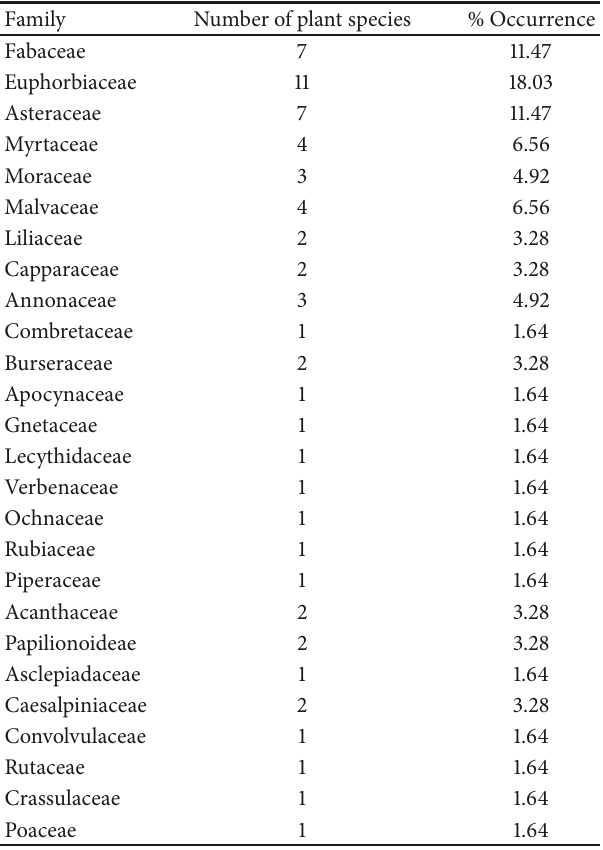
Table 2: The list of family, number of the plant species, and their percentage